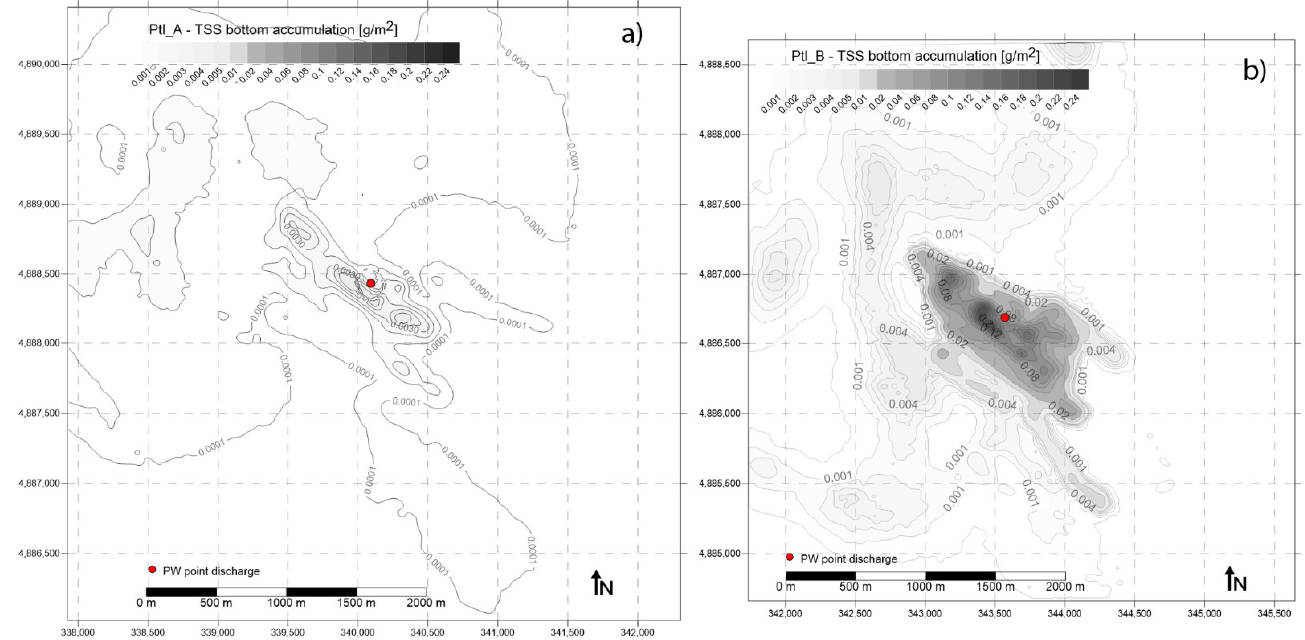
Figure 18. Map (WGS 84 UTM 33N) of TSS bottom accumulation in one month for: ( a ) Plt A and ( b ) Plt B by MIKE 3 PT module.